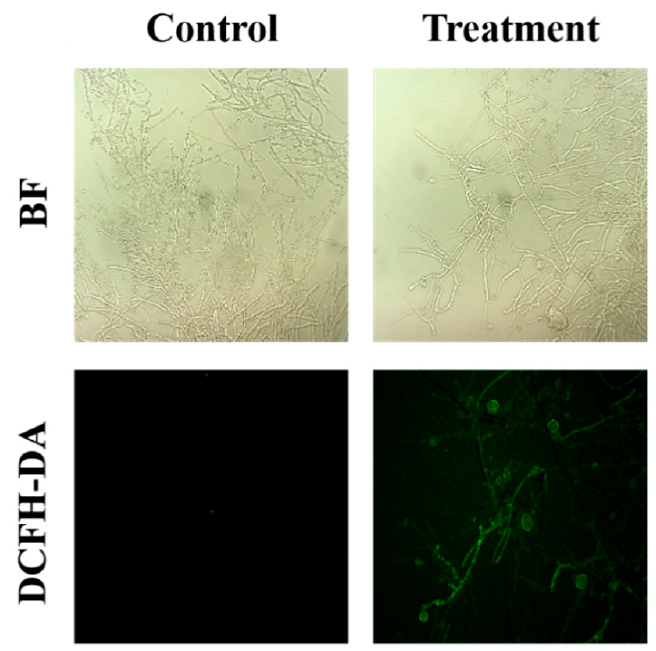
Figure 4. Effect of B. subtilis XZ18-3 sterile filtrates on ROS accumulation in R. cerealis . The fluorescence excitation wavelength is 448 nm.